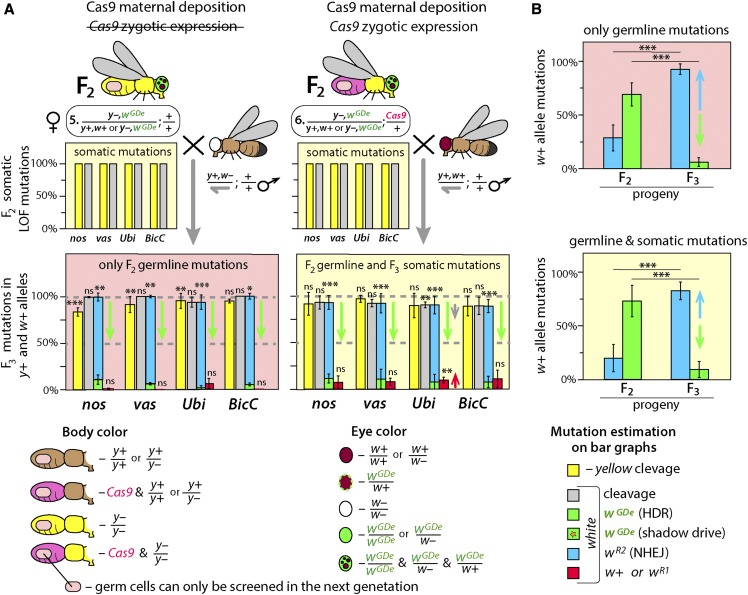
Resistance alleles accumulates over subsequent generations and restricts homing. Resistance alleles are expected to be immune to the further cleavage by the same Cas9/gRNA system and if their carrier is fertile can propagate at the expense of homing. (A) To explore this phenomenon, F2 ♀ #5 and F2 ♀ #6 collected among progeny of F1 ♀ #2 were genetically crossed with w– and w+ males, respectively, and their F3 progeny were scored. While the cleavage rate in F2 germ cells decreased only in F2 ♀ #6 with Ubi-Cas9 (red arrow) likely due to the rise of functional wR1 alleles, the homing frequency fell significantly for each tested split-drive system with and without Cas9 gene (green arrows). The fall of homing rate was accompanied by the accumulation of the wR2 alleles. (B) Accumulation of wR2 alleles resistant to cleavage by Cas9/gRNAw restricted homing of GDe. Frequencies of homing and resistance alleles were averaged for all tested promoters and presented separately for progeny of heterozygous and trans-heterozygous females, F2 ♀ #5 and F2 ♀ #6, respectively. Resistance allele frequency increased from 28.5% or 19.9% to 92.6% or 82.6%, respectively, between F2 and F3 (blue arrows) and caused the dramatic decline in homing from 69.0% or 73.0% to 6.1% or 9.2%, respectively (green arrows). Notably, scoring of wR2 alleles in w– recessive background resulted in the higher estimation of white LOF mutations alleles, since wR2 alleles were complemented by w+ alleles inherited from wild type males. Bar plots show the average ± SD over at least three biological replicate crosses. Statistical significance was estimated using a t-test with equal variance. (P ≥ 0.05ns, P < 0.05*, P < 0.01**, and P < 0.001***).